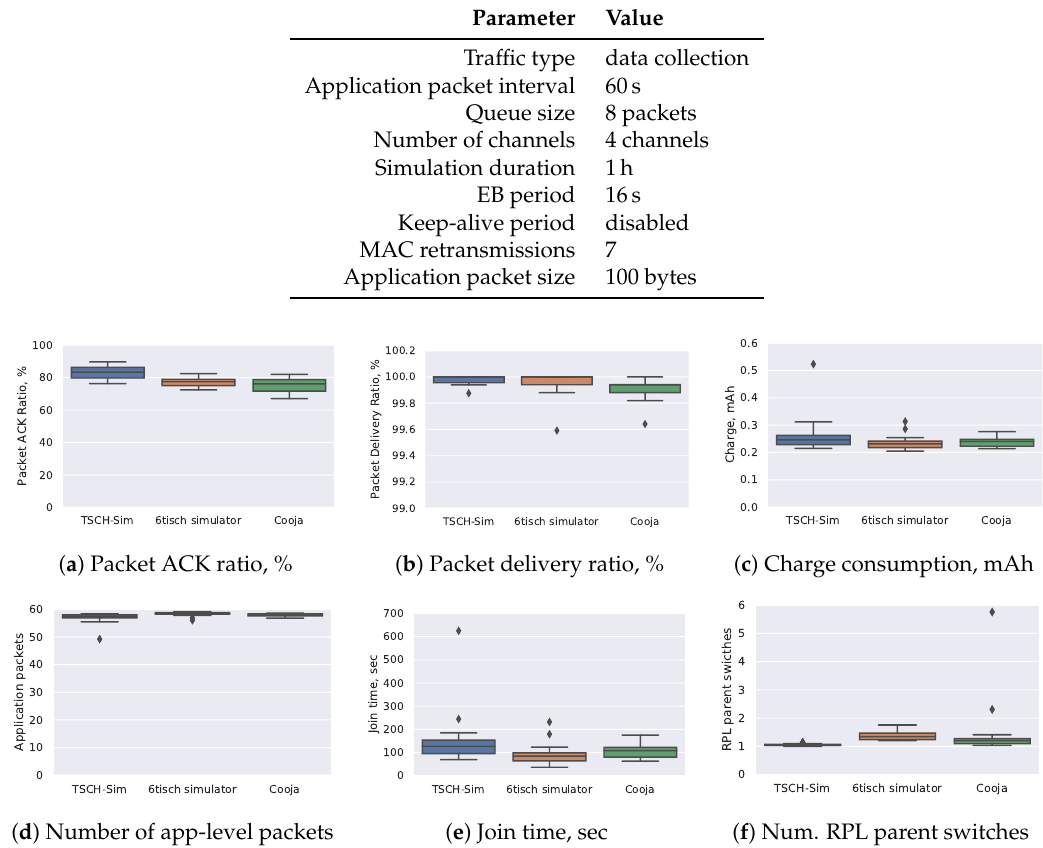
Figure 6. Comparison of results of 1h long simulations in random 30-node